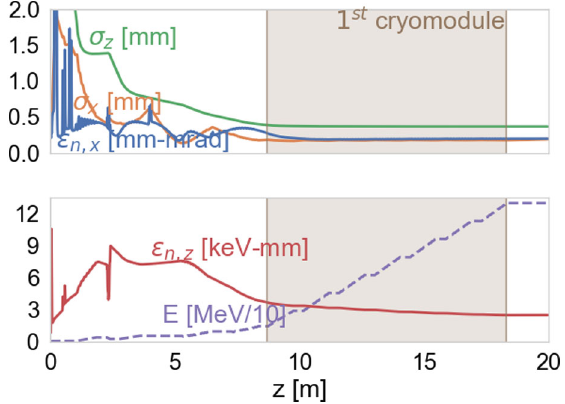
FIG. 5. The upper plot shows beam envelopes and energy gain in the L1 booster and in the HHL. The lower plot exhibits the same beam parameters for the beam back from the BAC, experiencing a second passage inside L1 and HHL. The plots point out as rf ponderomotive forces and SC solenoid focusing effects, remaining unchanged for the two different directions, perfectly constraint beam